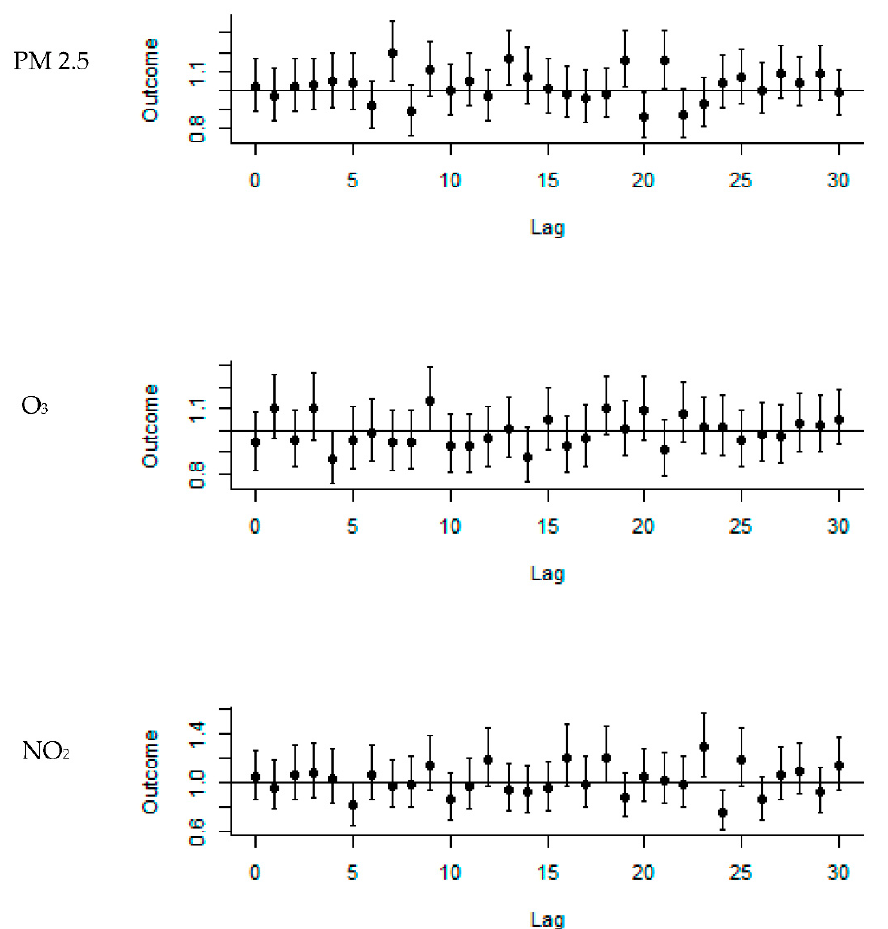
Figure 2. The lag effects of SSHL after air pollution exposure.